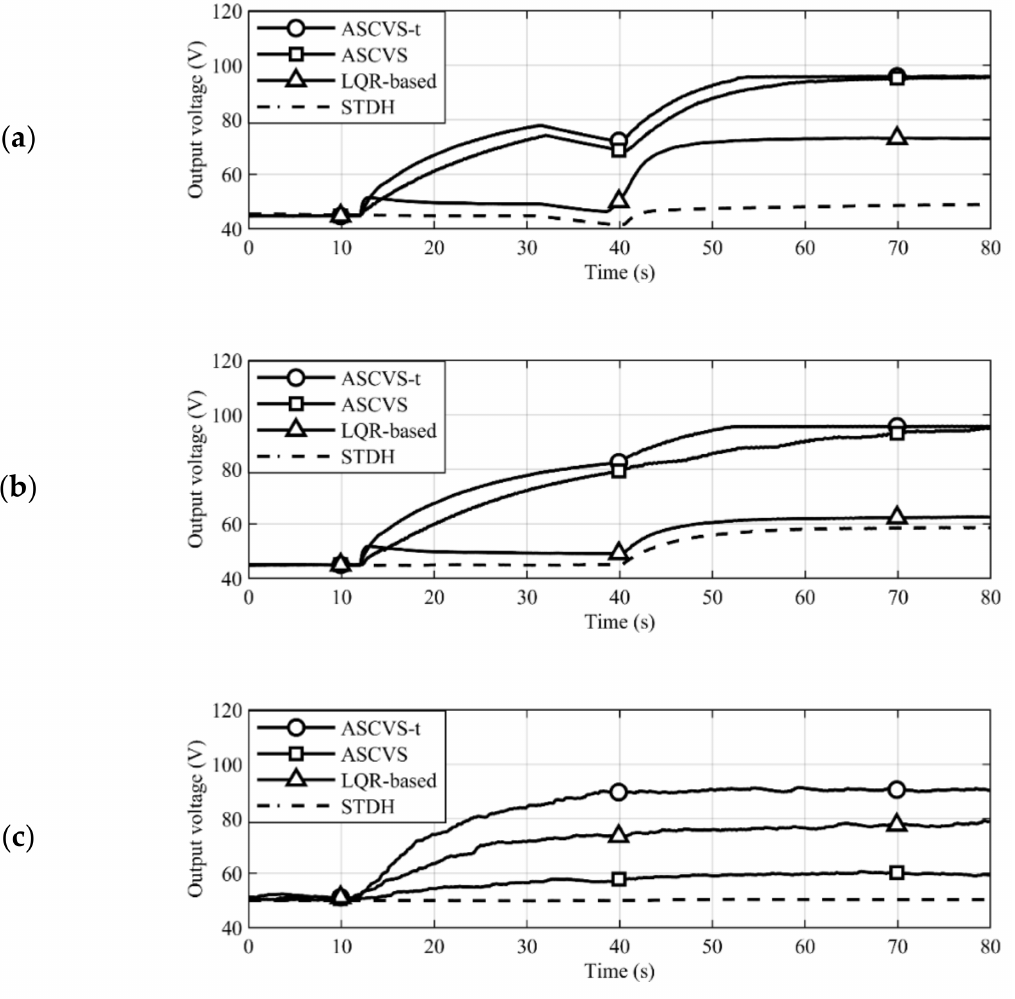
Figure 7. Time histories of output with each switching strategy. ( a ) Frequency sweep experiment. ( b ) Experiment on change in the number of dominant frequencies. ( c ) Random